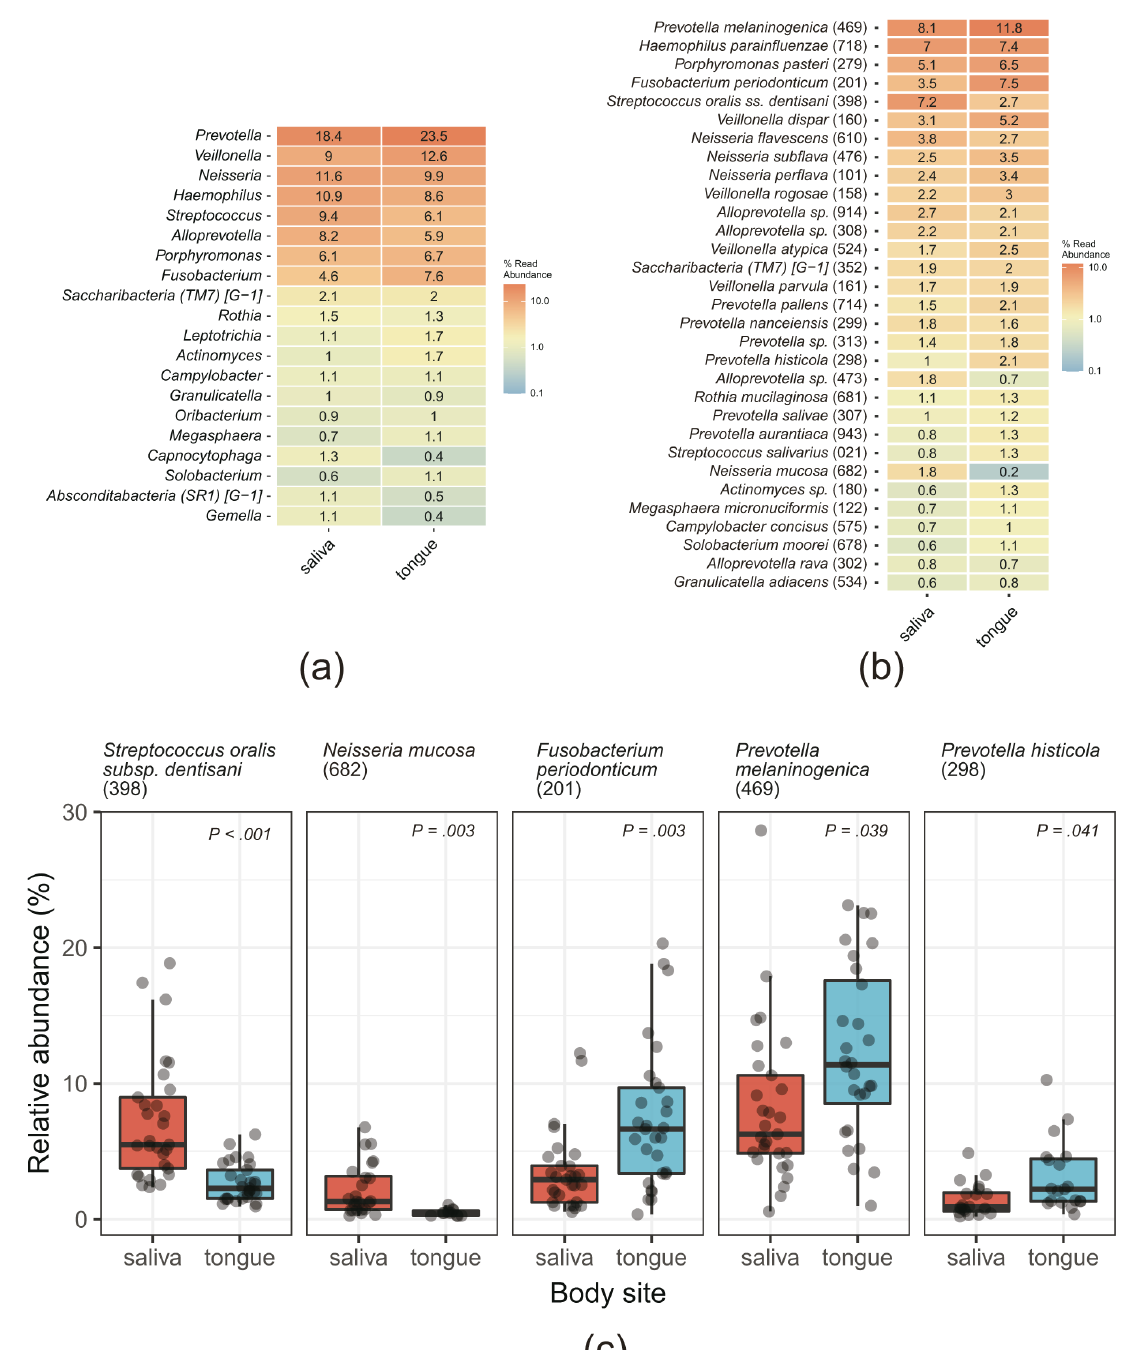
Figure 4. Abundances of bacterial taxa in the salivary and tongue microbiomes. The clustered operational taxonomic unit (OTU) table was used for calculations. ( a , b ) Heatmaps of the abundance of bacterial taxa at the genus ( a ) or species ( b ) levels. The % read abundances are indicated, together with a color gradient. In ( b ), the counts of clustered OTUs with the same Taxon ID were aggregated. ( c ) Box plots summarizing the abundance of OTUs that were differentially abundant ( P < 0.05, Kruskal–Wallis test with Benjamini–Hochberg adjustment) in the saliva and tongue samples at the species level are shown. Each dot indicates a sample. Taxon IDs in eHOMD are indicated in the